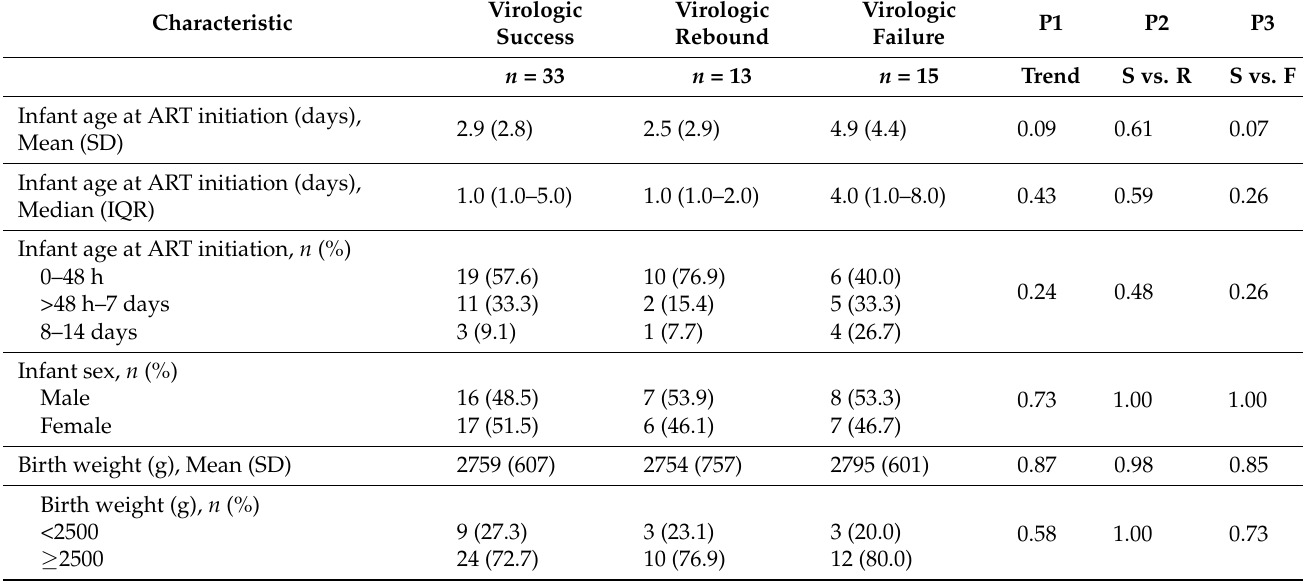
Table 2. Factors associated with viral response following clinically meaningful viral load endpoints (virologic success, virologic rebound, and virologic failure) by 72